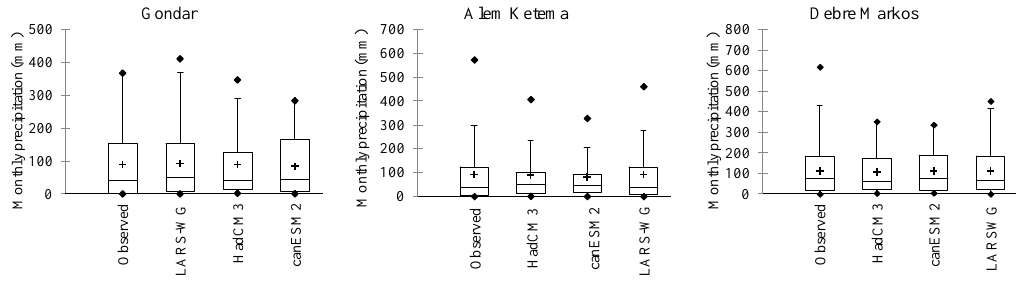
Figure 10. Box plot showing the model performance for three stations on a monthly basis. Box boundaries indicate the 25th and 75th percentiles, the line within the box marks the median, whiskers below and above the box indicate the 10th and 90th percentiles, and dots indicate the extremes.